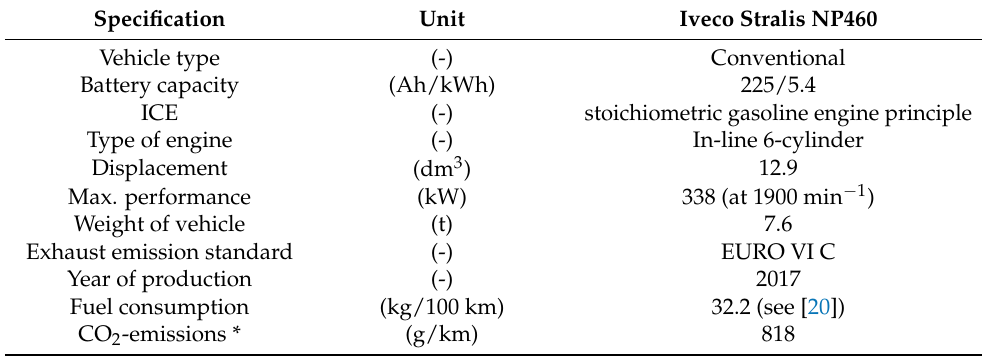
Table 3. Main characteristics of the reference vehicle (natural gas HDV; *: calculation).